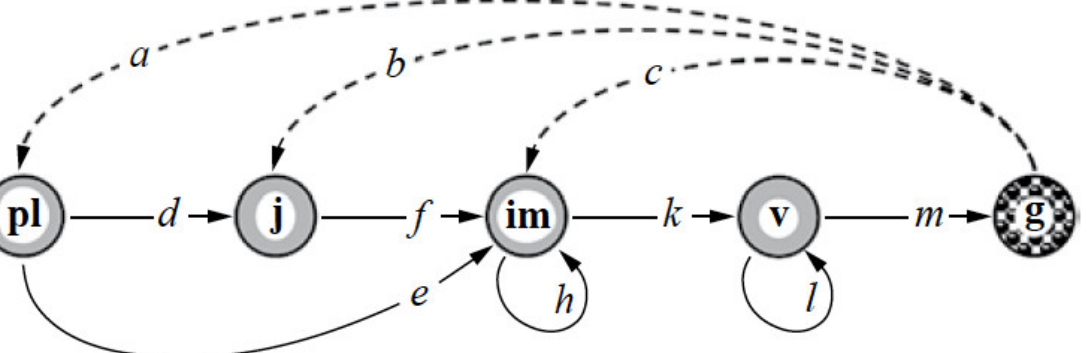
Figure 1. Life cycle graph for a local population of Androsace albana , an alpine short-lived perennial species, observed once a year. Ontogenetic stage notations: pl , seedlings; j , juvenile plants; im, immature plants; v, adult vegetative plants; g , generative plants, the stages being distinguishable in the field. Solid arrows indicate transitions occurring for one year (no transition, in particular); dashed arrows correspond to the annual population recruitment [5].